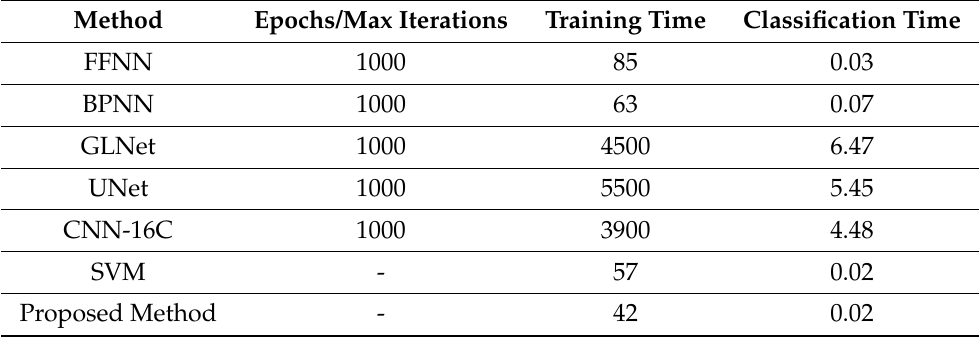
Table 7. Performance in terms of the mean time required by each classifier for training and single-instance classification, measured in